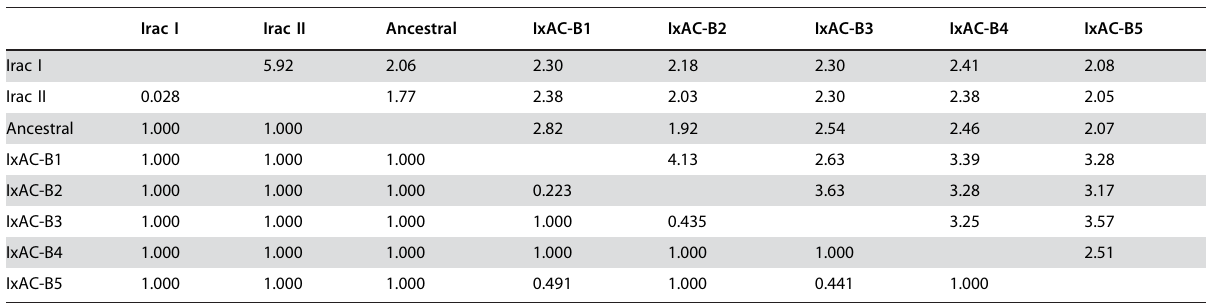
Table 4. Evidence for positive selection in I. ricinus IxAC coding sequences. .. ... .... ... ... .... ... ... .... ... ... .... ... ... .... ... ... .... ... ... .... ... ... .... ... ... .... ... ... .... ... ... .... ... ... .... ... ... .... ... ... .... ... ...